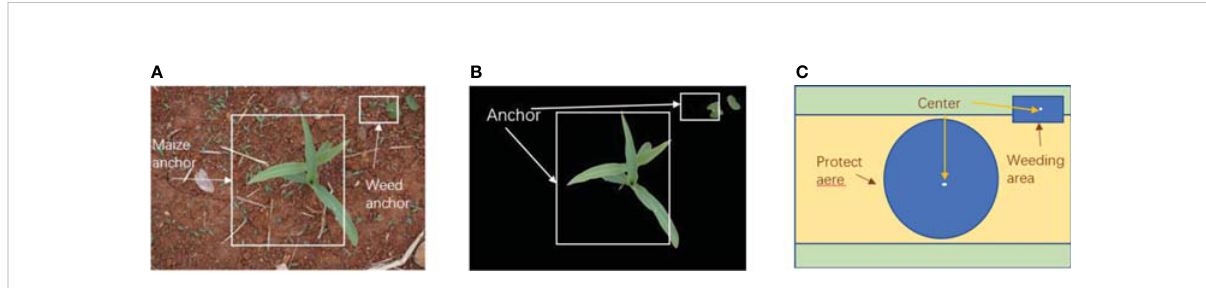
FIGURE 7 Determination of protected areas and weeding areas (A) . Output the anchor box (B) . Remove the background (C) . Form protected areas and weed areas.